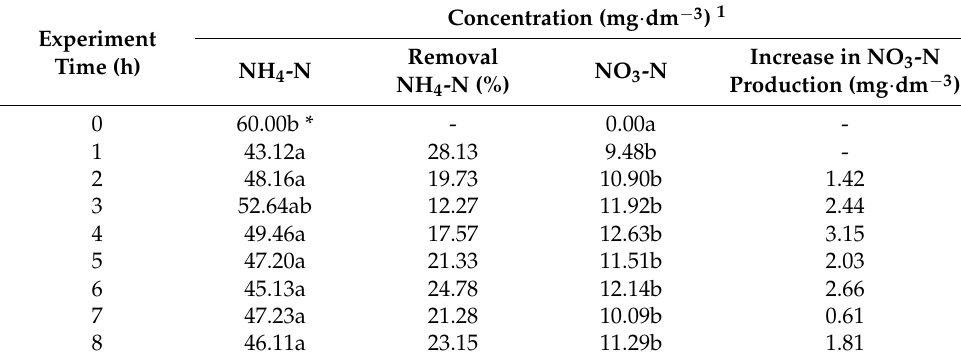
Table 5. The effect of ammonium nitrogen at a concentration of 60 mg · dm − 3 on the activity of nitrifying bacteria—dynamic conditions.